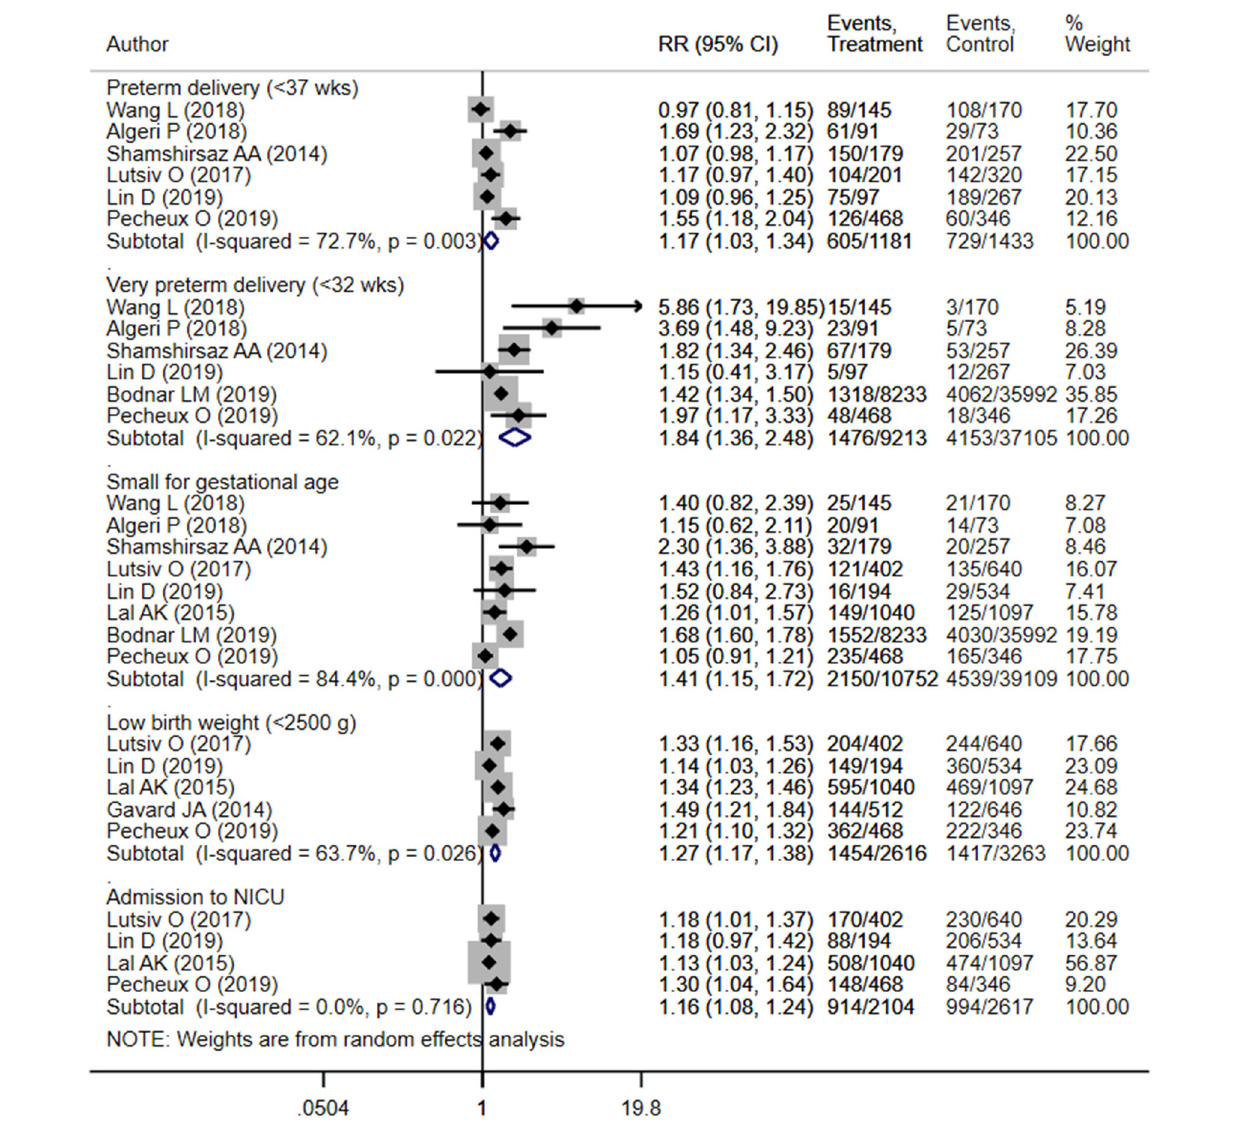
pooled mean birth weight (in grams) (WMD 42.3; 95% CI: − 16.2, 100.8; I 2 = 90.3%; N = 5) was higher by roughly 42 grams, no statistically significant difference was observed ( Figures 8 , 9